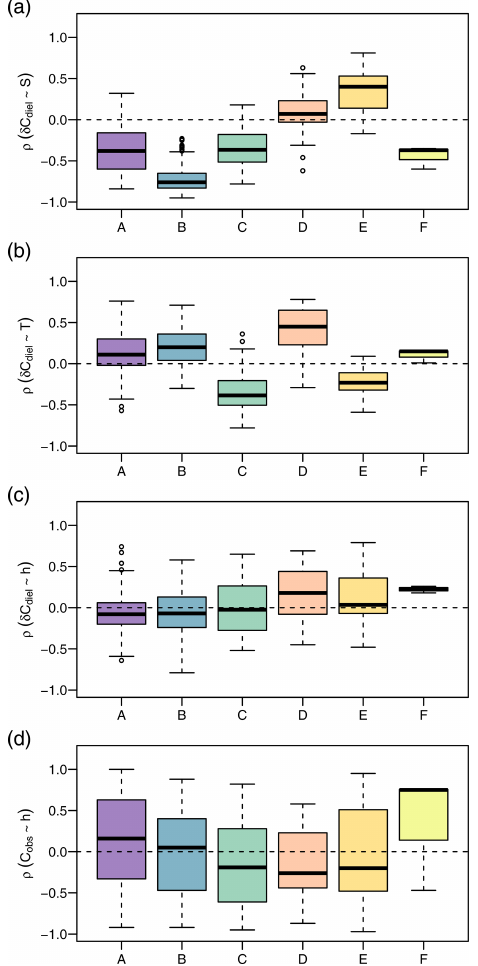
Figure 6. Daily Spearman correlations of the NO − tential drivers by cluster. The panels show correlation strength of diel concentration change rate with global irradiance (a) , diel con- centration change rate with water temperature (b) , diel concentra- tion change rate with water level (c) , and observed concentration with water level (d)